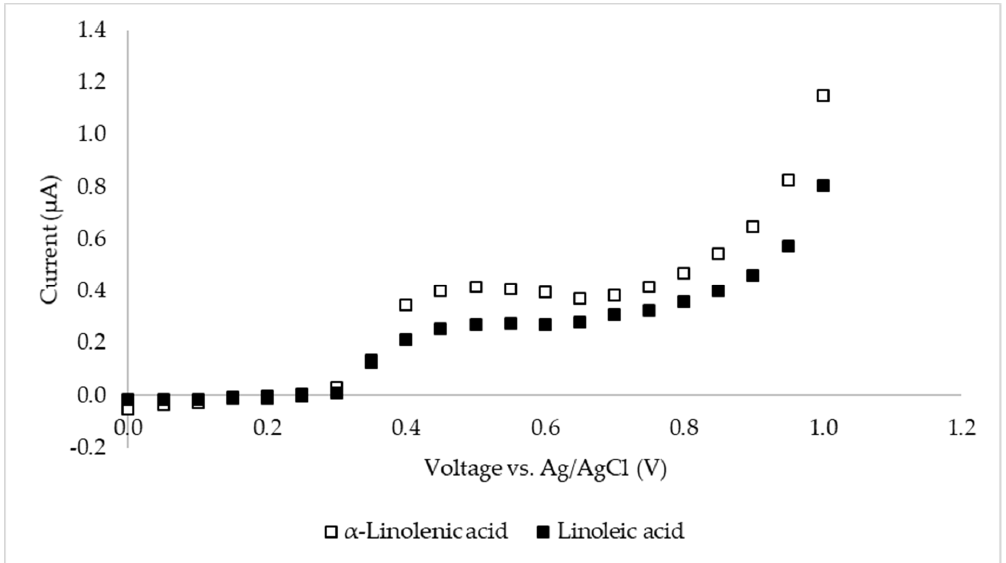
Figure 5. Hydrodynamic voltammograms obtained for: (white) α-linolenic acid and (black) linoleic acid both a concentration of 100 µM; the supporting electrolyte consisted of 0.1 M phosphate buffer pH 7.0 containing 0.1 M NaCl, using a cobalt phthalocyanine screen-printed carbon electrode with 15,000 units of lipoxygenase.